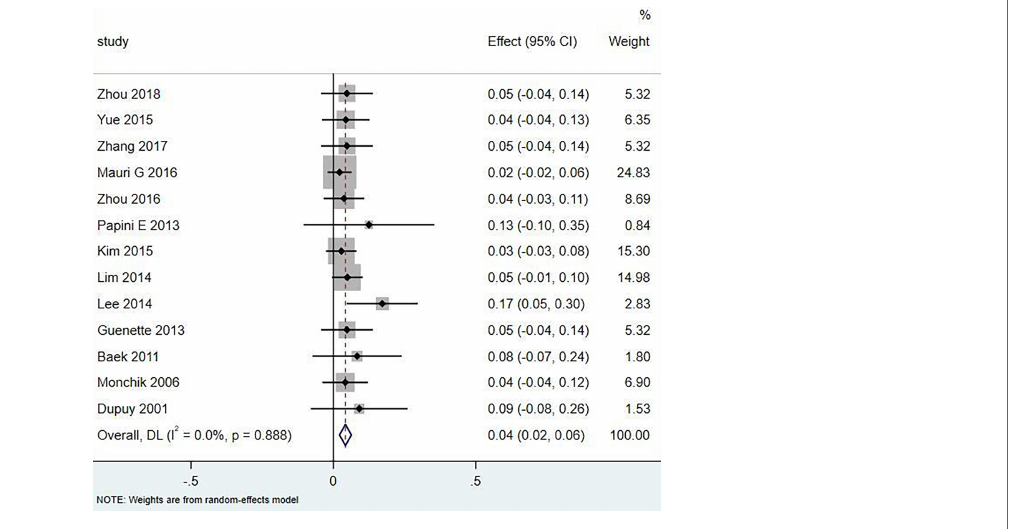
FIGURE 6 | Major complication rate of thermal